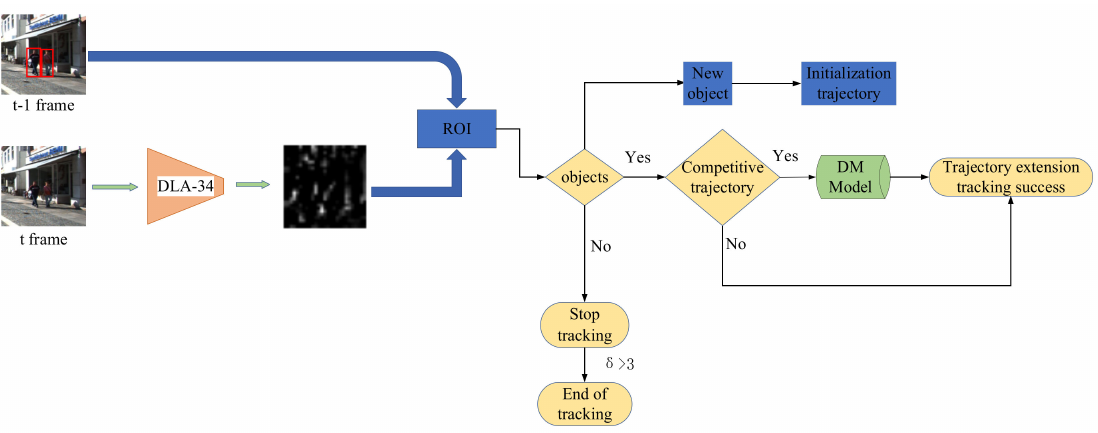
Figure 5. Simplified ours pipeline.